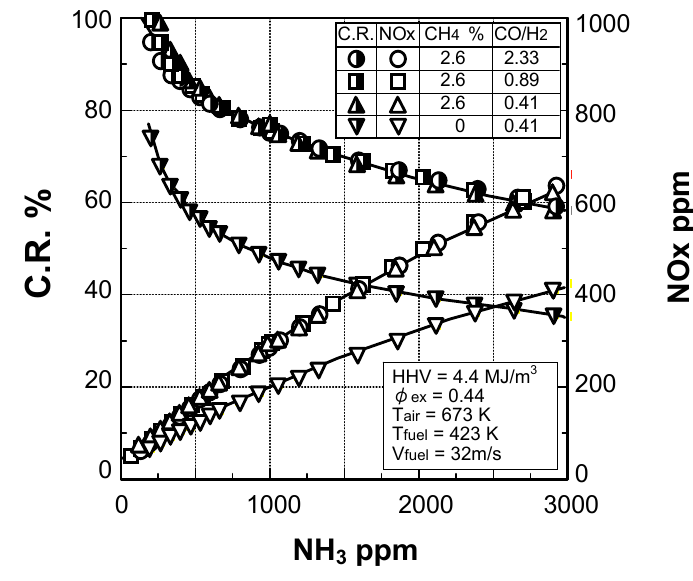
concentration on conversion rate of NH 3 molar ratio as parameters defining by 2